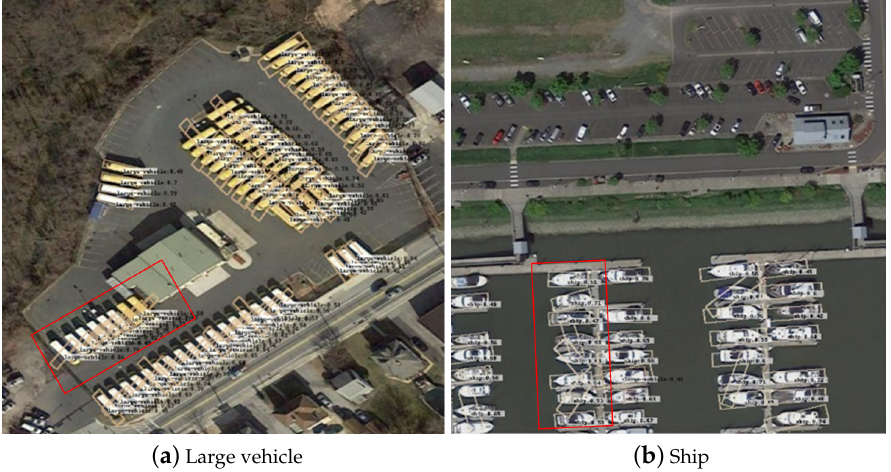
Figure 7. The regression inaccuracy of the five-parameter method. RetinaNet is the base model. The cars and ships in the red box have not been accurately detected, and the angles between the prediction boxes and the ground truth are